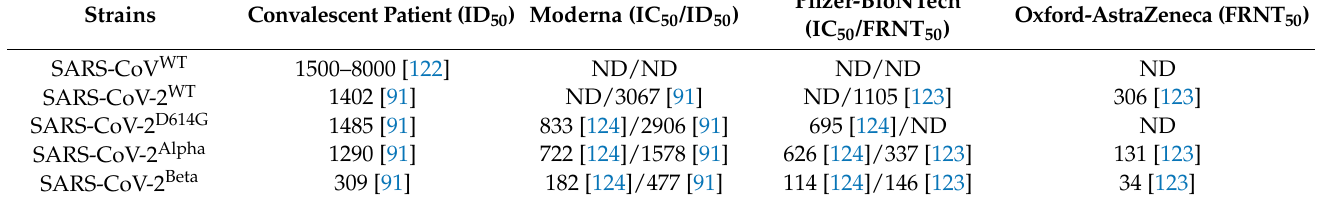
Table 3. Sensitivity of sera from convalescent patients and individuals vaccinated with Moderna, Pfizer-BioNTech and Oxford-AstraZeneca vaccines. The sensitivity of neutralizing antibodies pro- duced by convalescent patients or induced by vaccines is higher in ancestral SARS-CoV-2 and, in general, the performance of this sensitivity is worse against any SARS-CoV-2 variants.